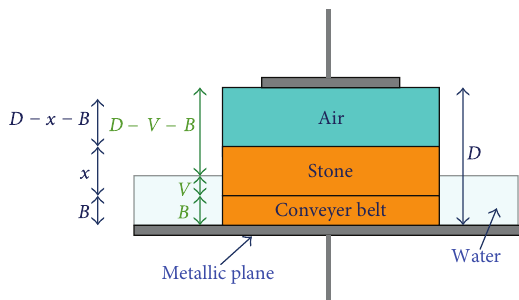
F 26: Multidielectric layer (air/stone/plastic belt) capacitive sensor inside the marble machine with